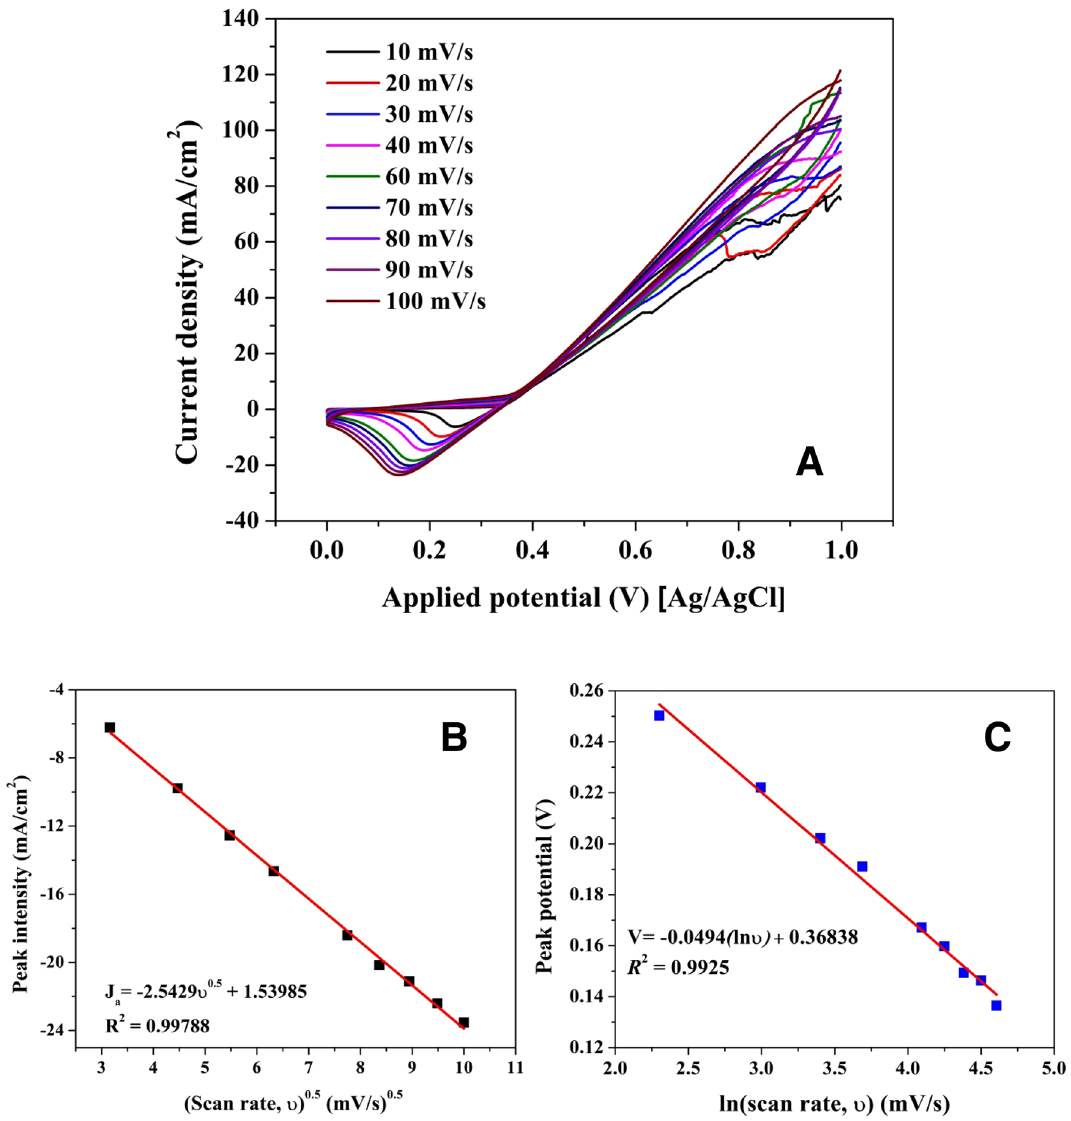
Figure 13. ( A ) Cyclic voltammograms of Mo 2 C/Ni-incorporated carbon nanofibers (25 wt%) at different scanning rates in 0.33 M urea (in 1.0 M KOH); ( B ) plots of J pa vs. scanning rates from ( A ); ( C ) Laviron’s plots of cathodic peak potential vs. ln v from ( A